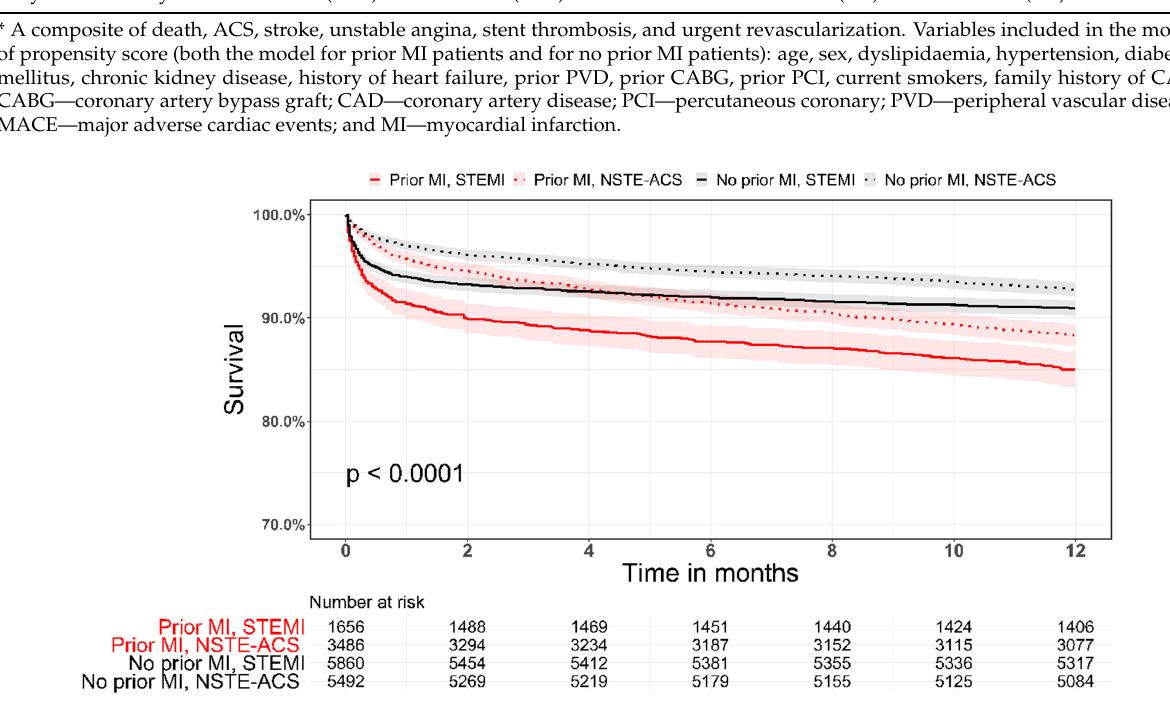
Figure 3. Kaplan–Meier survival curves stratified by prior MI status and by type of index ACS (STEMI/NSTE-ACS).